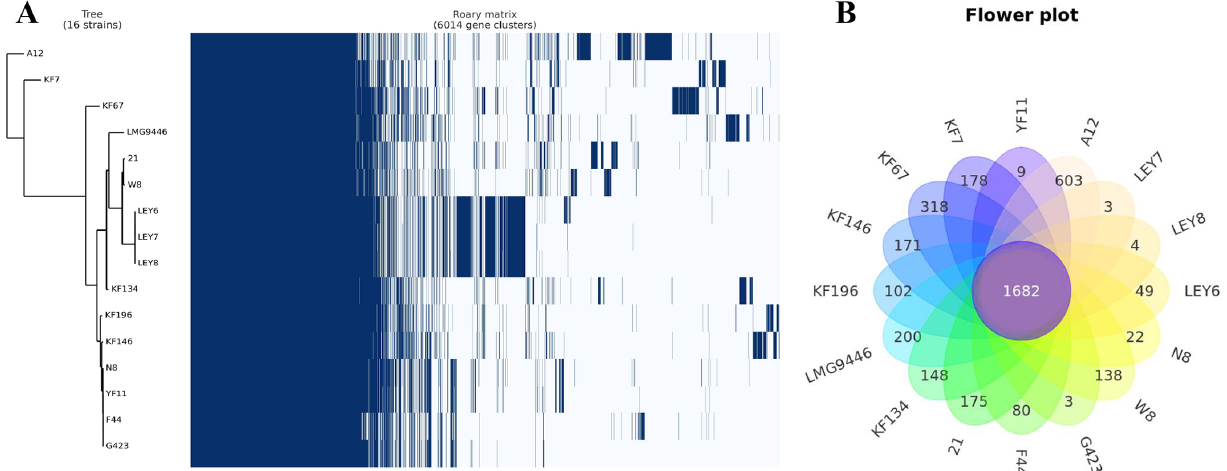
Figure 3. ( A ) Pan-genome matrix of 17 L. lactis . Blue, gene presence; white, gene absence. ( B ) Flower plot of 17 L. lactis .